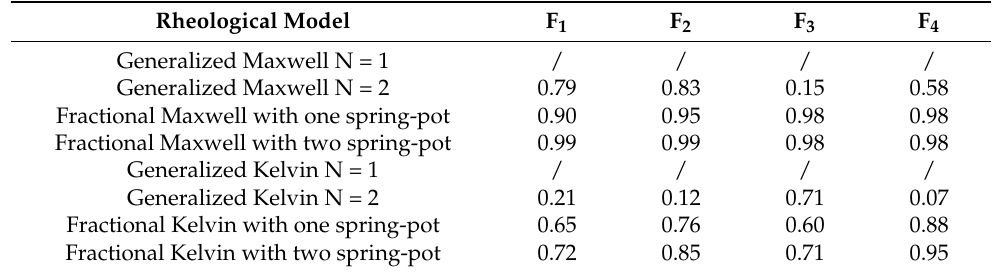
Table 3. R 2 for creep compliance models.